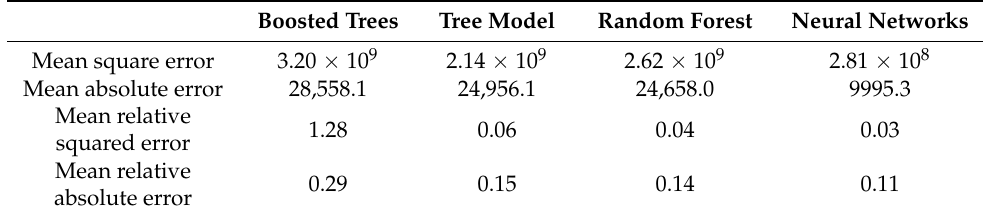
Table 5. Comparison of the prognostic capabilities of the models. Boosted Trees Tree